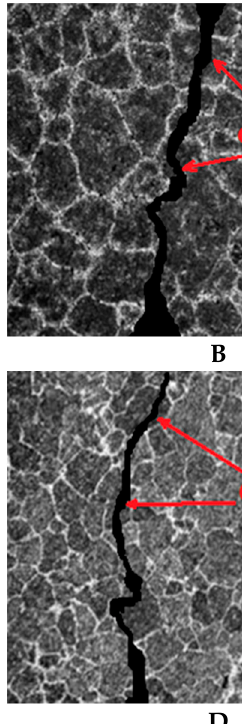
D Figure 7. Microstructural analysis of the failed surfaces of Al5083 alloy tested in air for the ( A ) as-received sample and samples after the ( B ) 1st pass, ( C ) 2nd pass, and ( D ) 3rd pass.